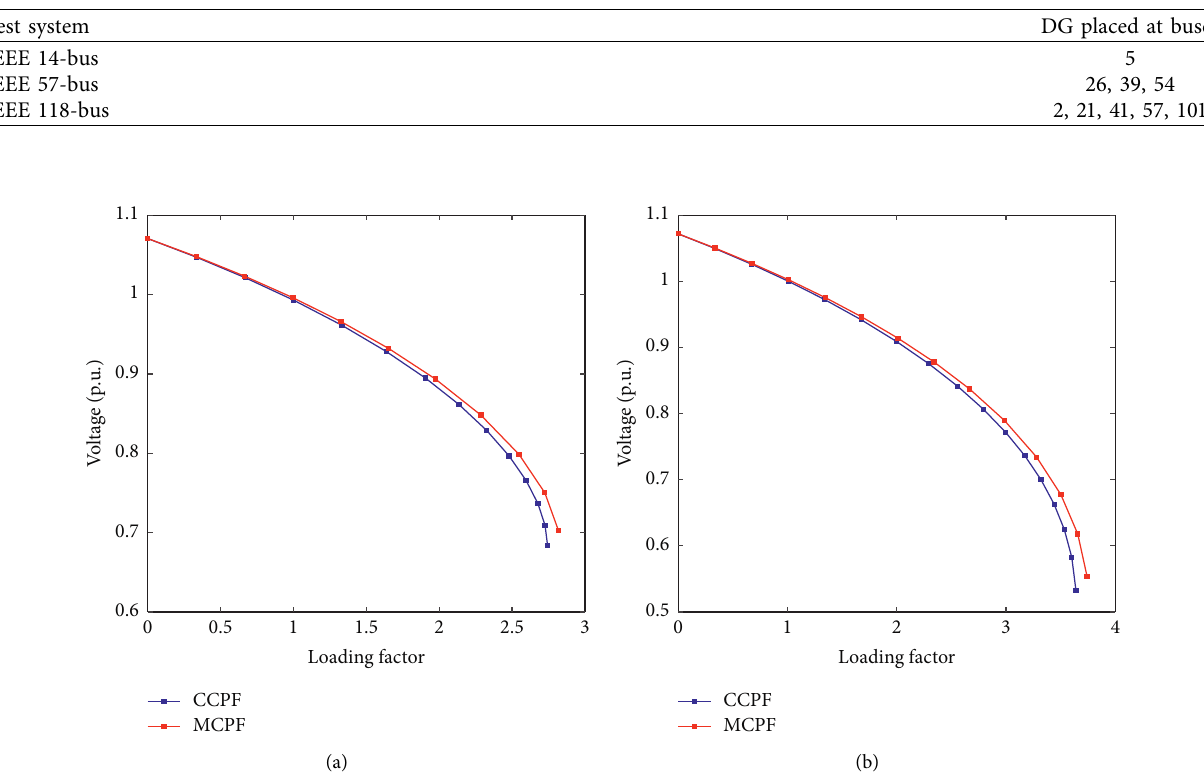
Table 1: The modification of the test systems.